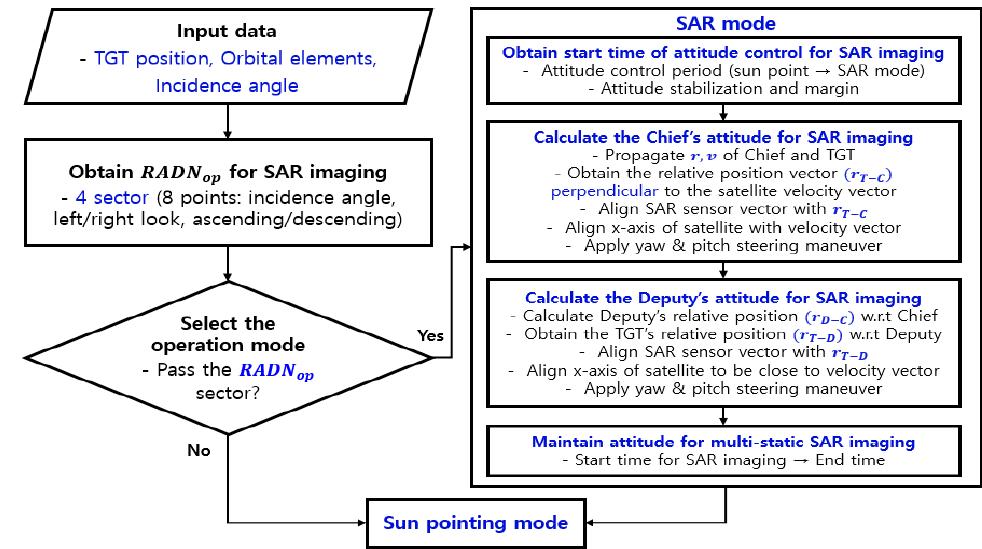
18 of 31 Figure 13. Difference in the accuracy of 𝑅𝐴𝐷𝑁 (cid:3042)(cid:3043) and 𝑒𝑝𝑜𝑐ℎ (cid:3020)(cid:3002)(cid:3019) obtained using the geometrical method (left) and geometrical plus numerical method (right). Squint angle error (top) and 𝜃 (cid:3036)(cid:3041)(cid:3030) error (bottom) at the 𝑒𝑝𝑜𝑐ℎ (cid:3020)(cid:3002)(cid:3019) of each imaging situation. 4.2. Attitude Control Strategy for Multistatic SAR Imaging Figure 14 shows a block diagram of the autonomous attitude-control strategy of the